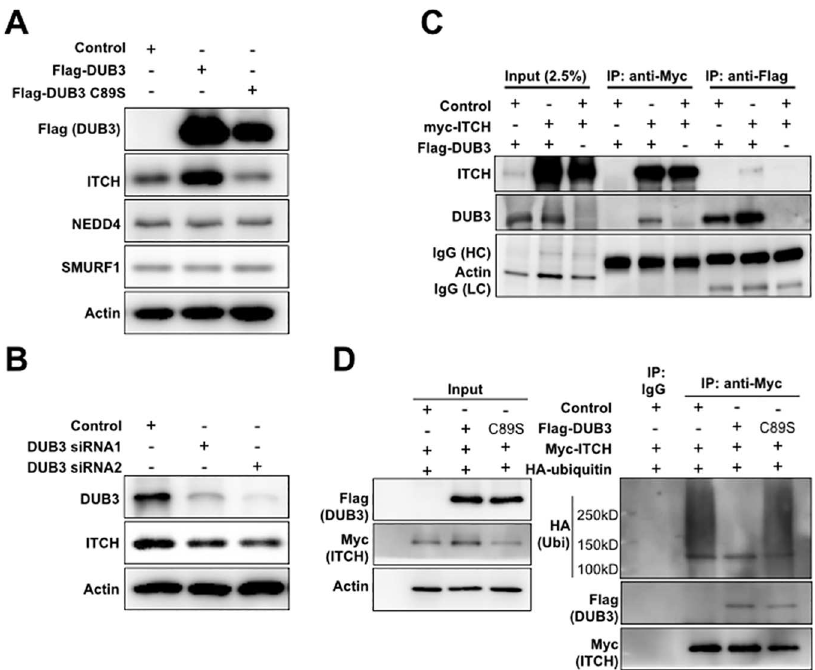
Fig 2. DUB3 interacts with ITCH and mediates its stability. (A) Immunoblots showingthe effect of DUB3 expressionon ITCH. HEK293T cells were transfected with a vector expressingFlag-DUB3,its C89S DUB3 or a control vector. Blots were probedwith anti-Flag, anti-ITCH, anti-NEDD4 and anti-SMURF1 antibodies. Anti-Actin was used to control for loading.(B) Immunoblots showingthe effect of DUB3 siRNAs on ITCH. HEK293T cells were transfected with independentsiRNAs againstDUB3 or a scrambledsiRNA. Blots were probedwith antibodiesagainst ITCH or Actin for loadingcontrol.(C) Immunoprecipitationassaysshowing interaction betweenDUB3 and ITCH. HEK293Tcells weretransfected to expressFlag-taggedDUB3 and Myc- taggedITCH as indicated.Transfected cells weretreated with MG1325 μ Movernightbeforebeingharvestedfor immunoprecipitationwith anti-Flagor anti-Myc-conjugatedbeads.Blots were probedwith anti-Flag to detect DUB3 or anti-Myc to detect ITCH. (D) Ubiquitylation assayshowingthe effect of DUB3 on ITCH ubiquitylation. HEK293Tcells were co-transfected with a vector expressingMyc-ITCH and a vector expressing Flag-tagged DUB3,Flag-tagged DUB3 C89Sor a controlvector. Transfected cells weretreated with MG1325 μ Movernight beforebeingharvested for immunoprecipitationwith anti-Myc-or isotypeIgG-conjugated beadsin PLC buffer freshlysupplemented with 10mM of NEM. Immunoblots were probedwith antibodiesagainstHA, Flag and